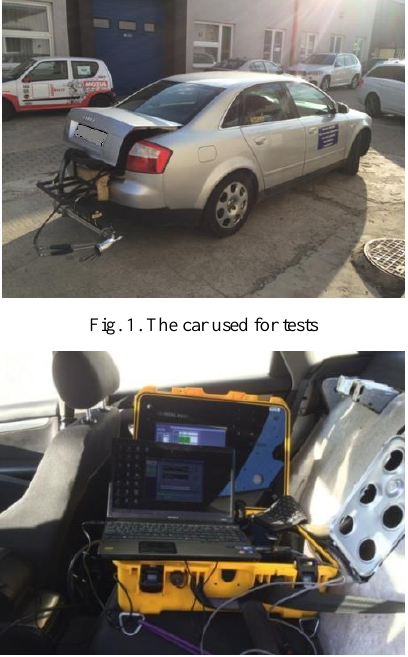
Fig. 2. View of the Axion R/S+ mobile device